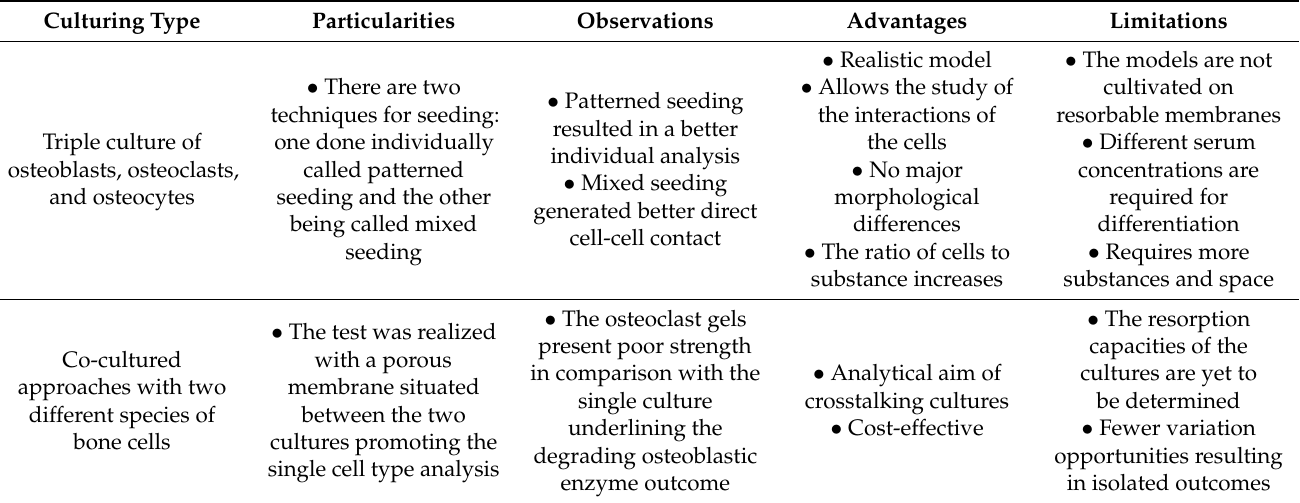
Table 1. Advantages and limitations of the culturing techniques. Created based on information from